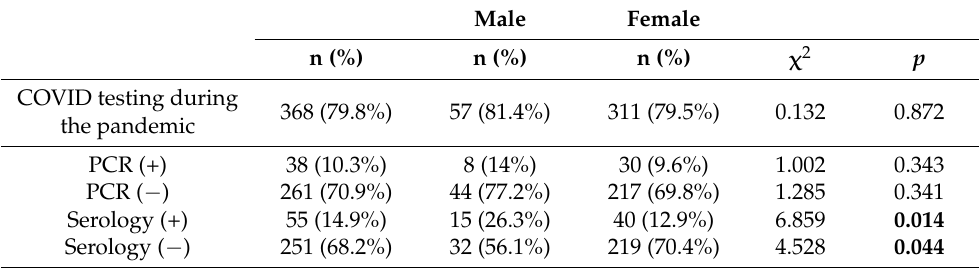
Table 3. PCR and serology tests performed on the professionals participating in the